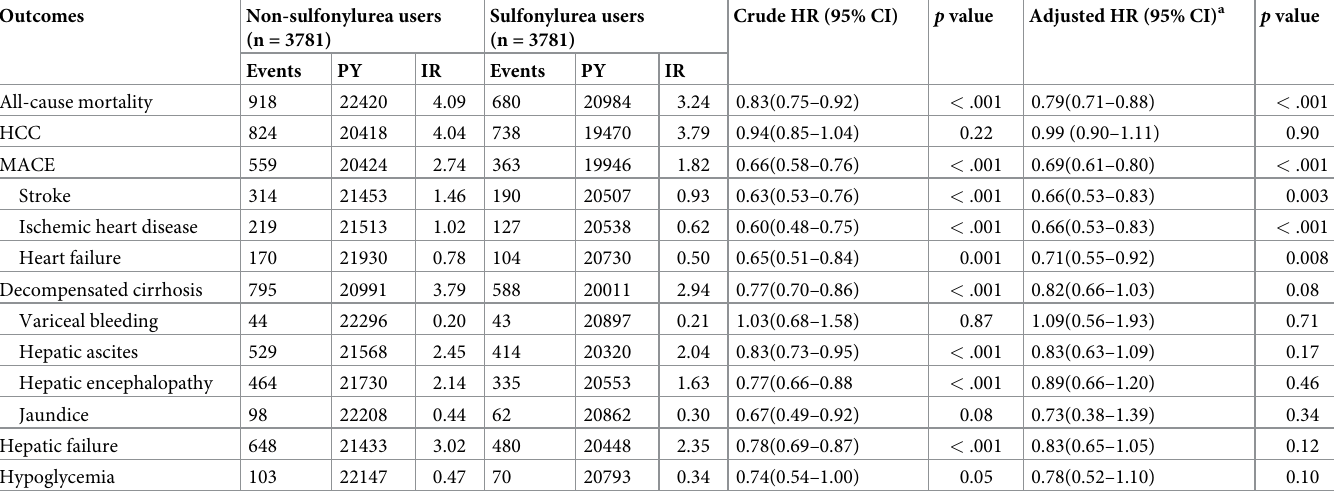
Table 2. Outcomes of sulfonylurea users versus matched sulfonylurea nonusers in patients with type 2 diabetes mellitus and compensated liver